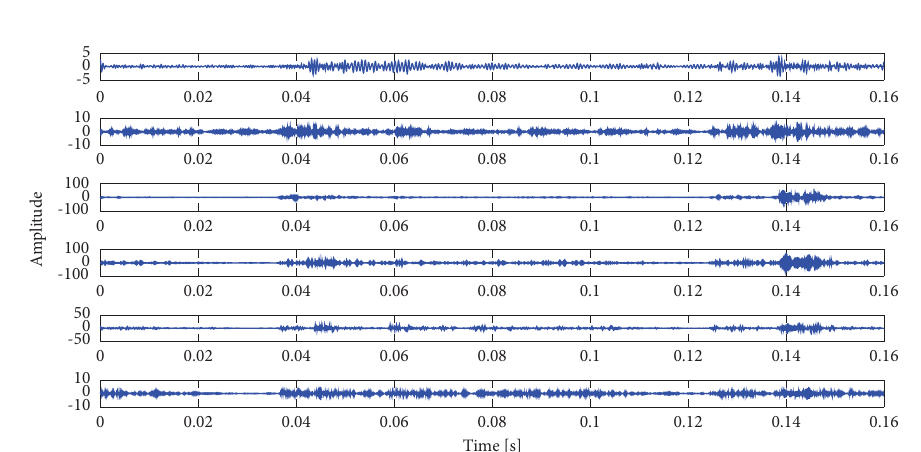
Figure 19: BLIMF components obtained by VMD.